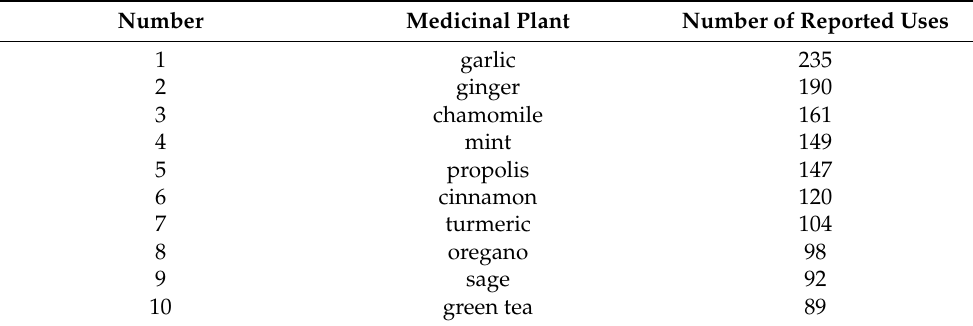
Table 5. List of most frequently used medicinal